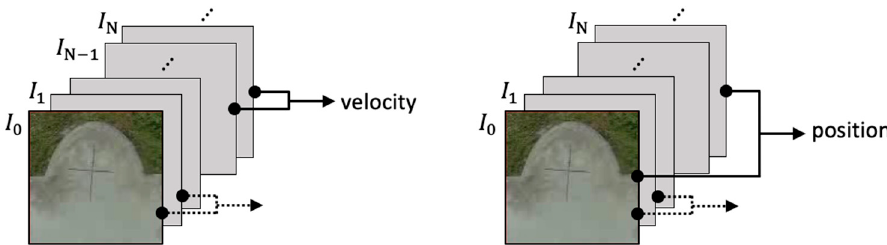
Figure 1. Overview of visual motion estimation: the velocity is obtained by comparing image patterns on two consecutive frames ( left ), and the position is computed by phase correlation method with respect to a reference image ( right ).